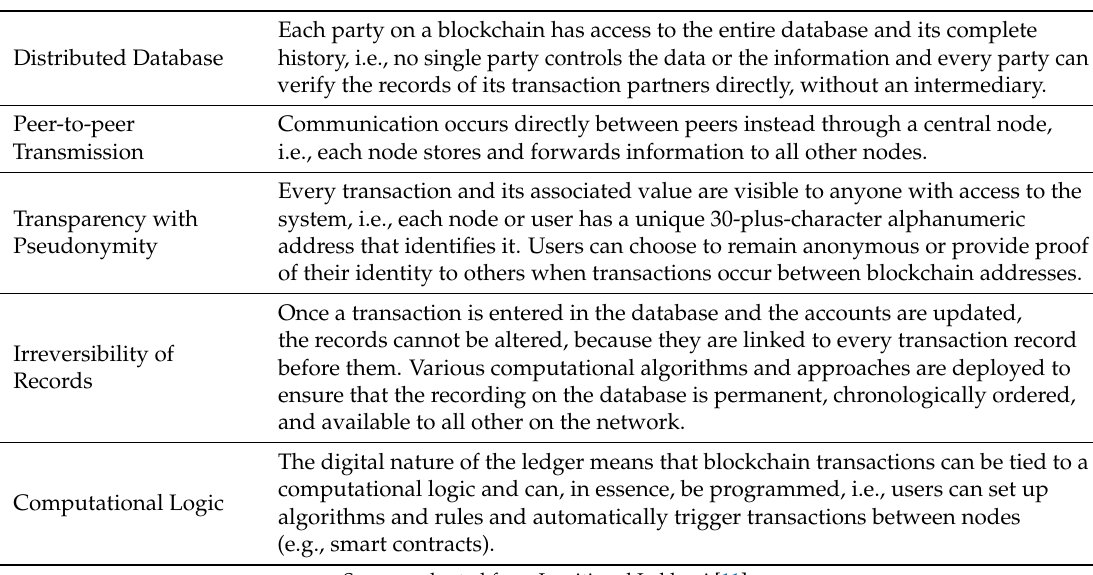
Table 1. Blockchain